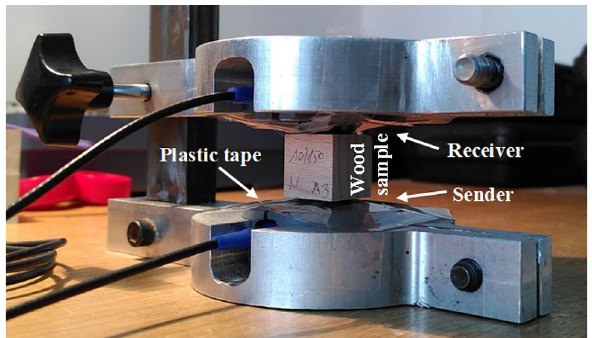
Figure 4. Ultrasound experimental